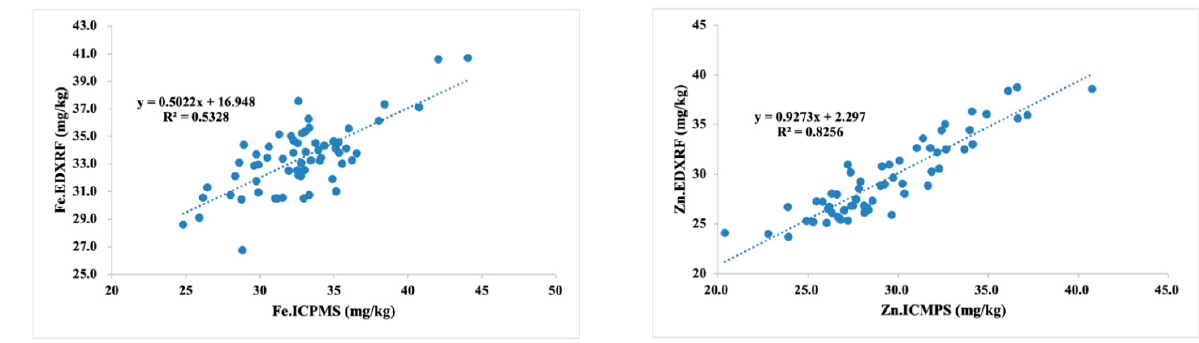
Figure 2. Coefficient of determination between two ICP-OES and EDXRF methods to predict grain iron (GFe) and zinc (Zn) in historical wheat cultivars released between 1911 and 2016.